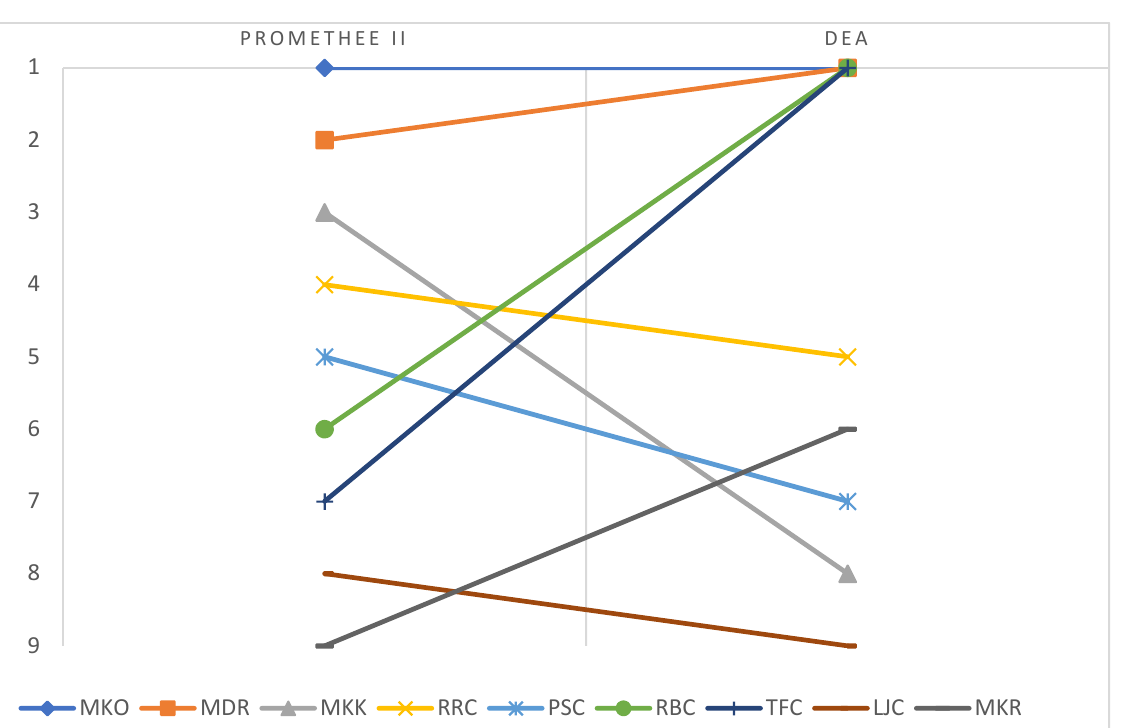
Figure 2. DCs ranking comparison with respect to PROMETHEE II, DEA, and DEA-based PROMETHEE II. The employment of the DEA as a fine-tuning instrument to adjust the previously implemented MCDM model, such as PROMETHEE II in the current study, can be considered as a unique contribution within the context of MCDM applications. Although such attempts are not commonly investigated in the MCDM literature, the results presented herein are compatible with two previously published works that assert a similarly unique involvement and employment of DEA with TOPSIS [44] and VIKOR [47] under fuzzy environments. Indubitably, the existence of such applications provides a sort of validation of the outcomes discussed in this paper. Several previous research works